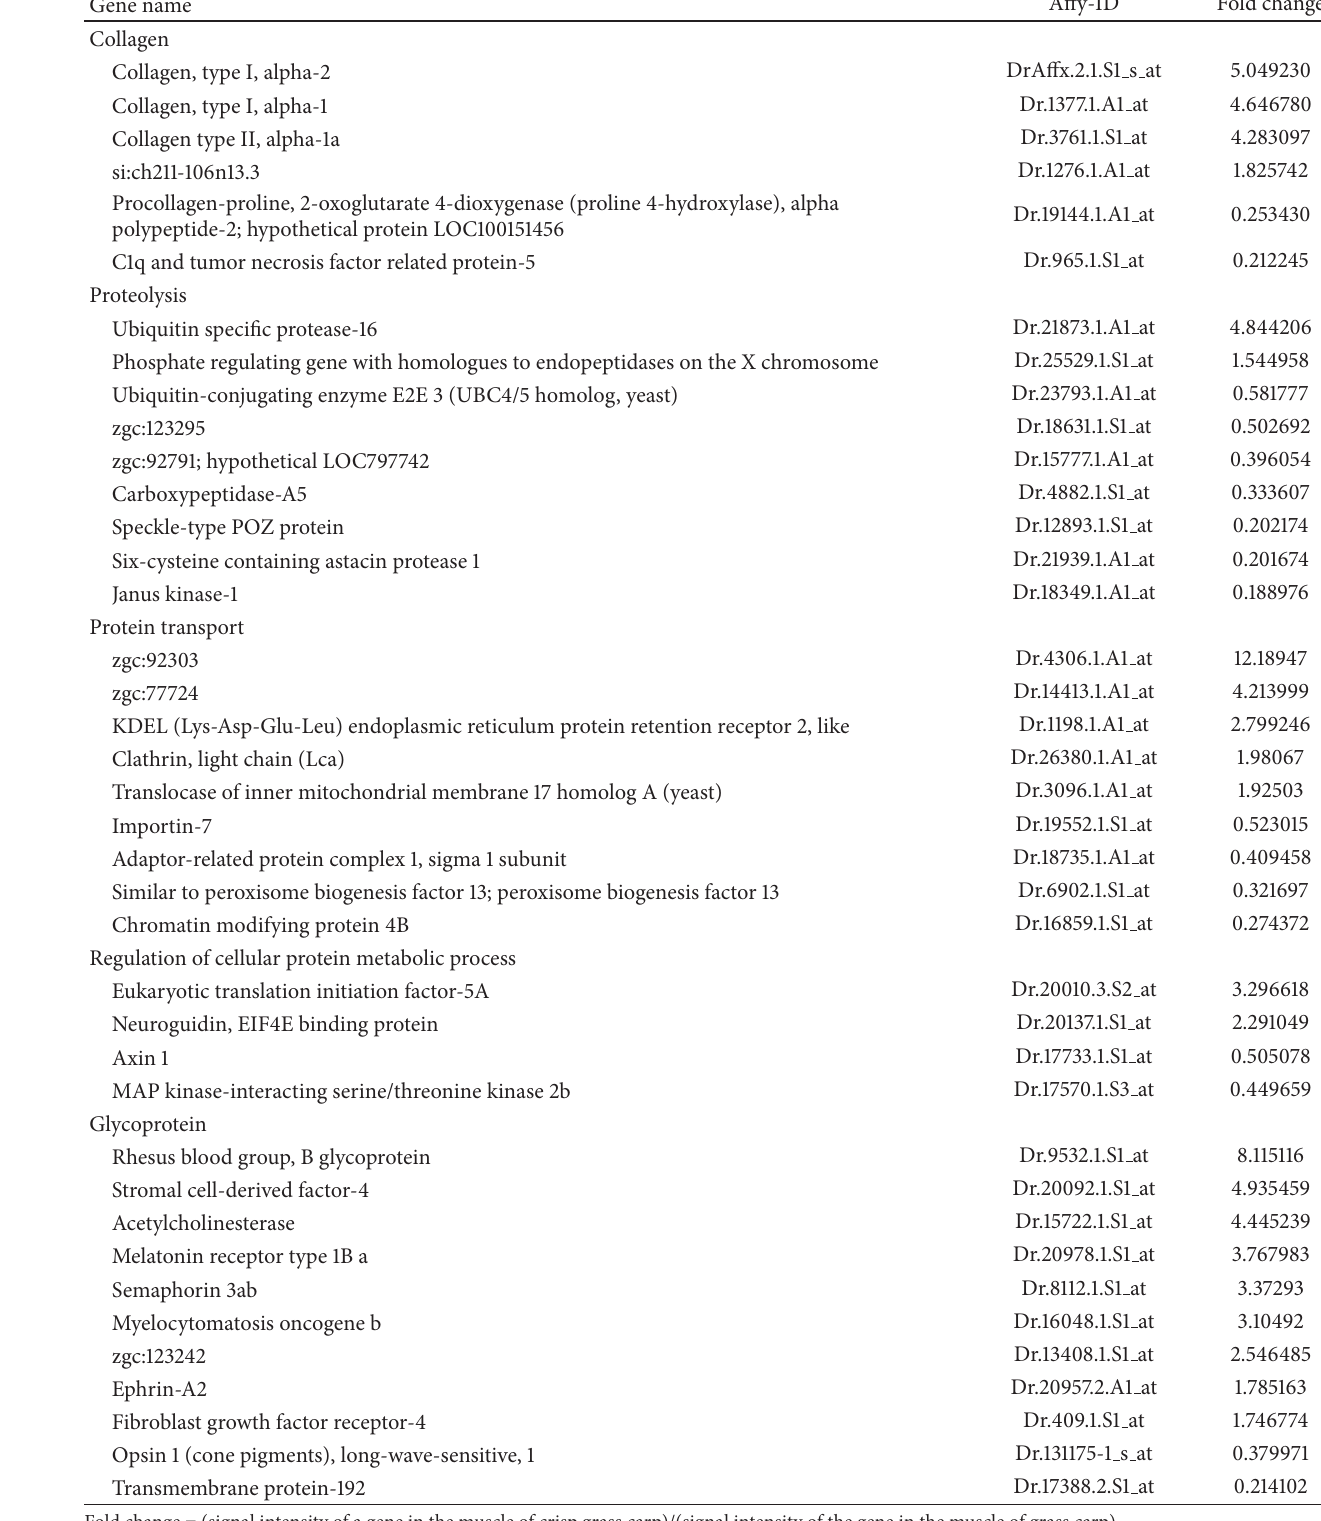
Table 2: Differentially expressed genes involved in protein metabolism in the muscle of crisp grass carp and grass